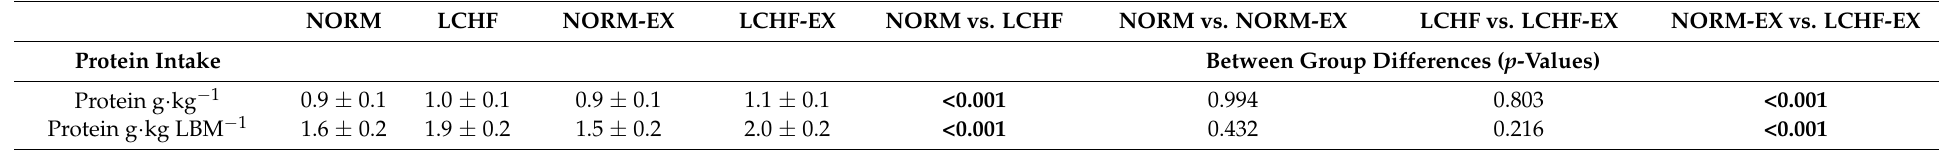
Table 6. Average protein intake in grams per kilogram of body weight and gram per kilogram of Lean Body Mass (LBM) during the